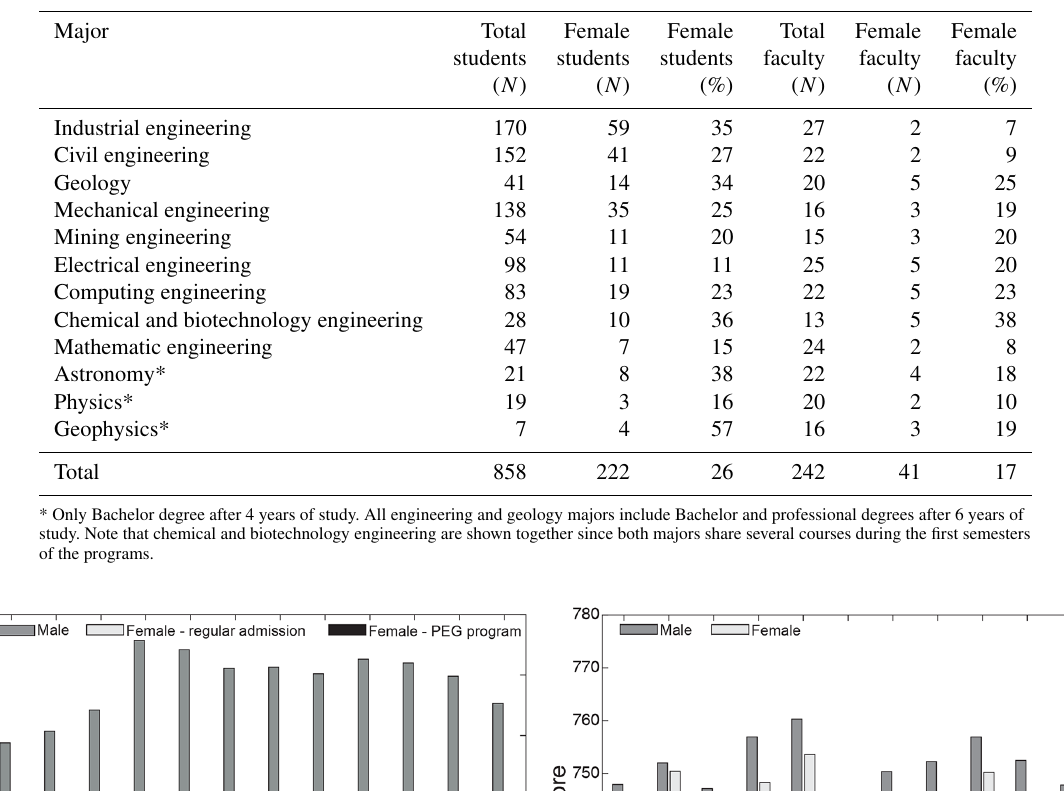
Table 1. Number of female students and faculty by major at FCFM in 2017.